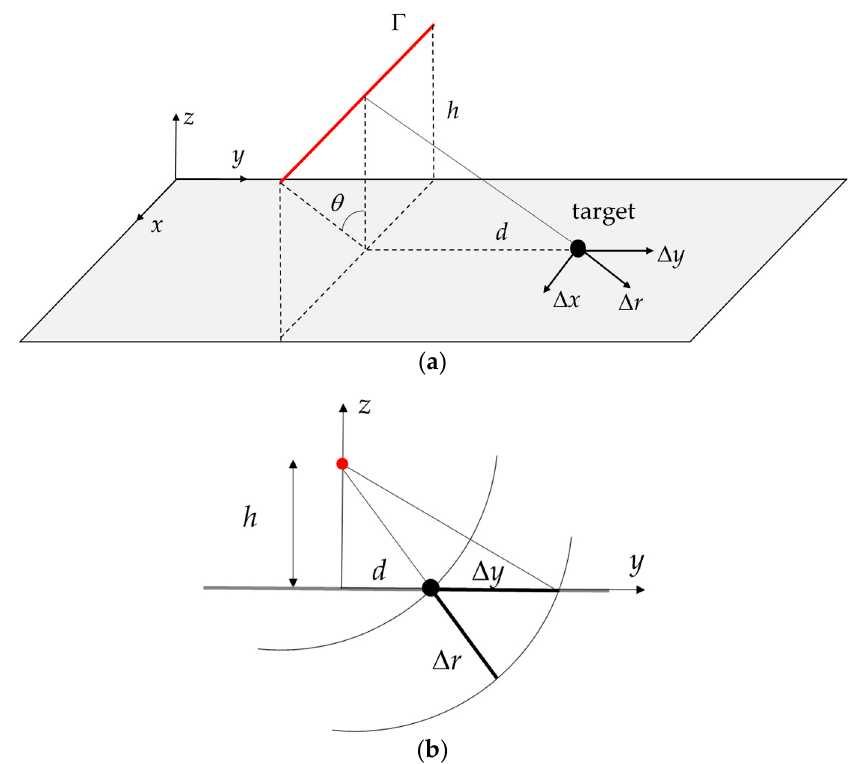
Figure 5. Radar imaging with an ideal rectilinear flight path: ( a ) 3D view; ( b ) view in the y – z plane.